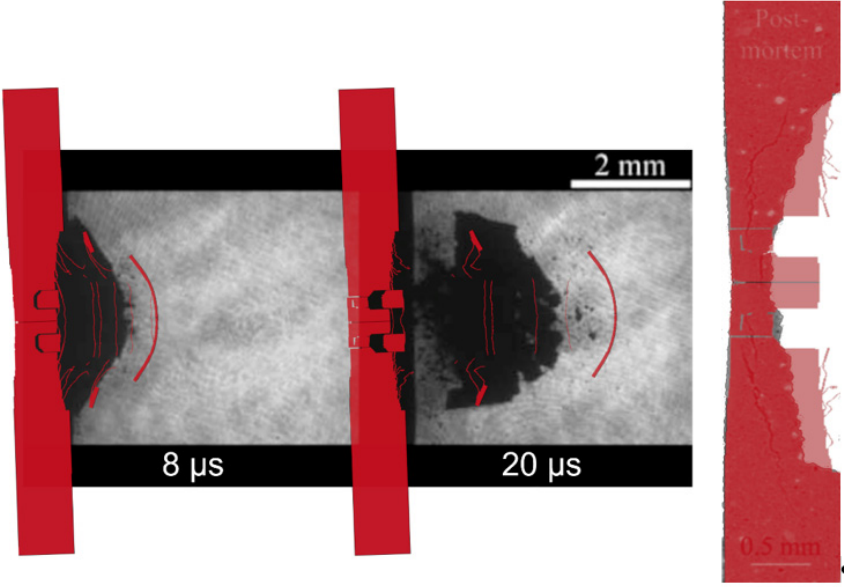
Figure 11. Shot S10 comparison between: numerical simulation results and shadowgraphies (reprinted from [28]) ( left ); post-mortem numerical simulation and tomography (reprinted from [28]) ( right ).